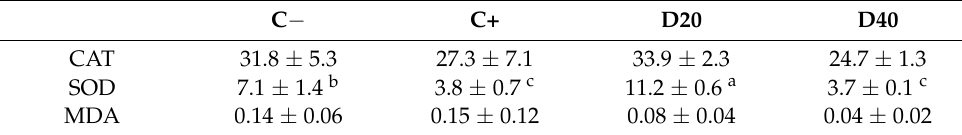
CAT, catalase; SOD, superoxide dismutase; MDA, malondialdehyde. Data obtained from five biological replicates are shown as the mean ± SE values ( n = 5). Different letters correspond to significant differences ( p < 0.05) according to Tukey’s HSD test. C − , control without high-density stress; C+, control under high-density stress; D20, experimental diet supplemented with 20 g/kg agavin under high-density stress; D40, experimental diet supplemented with 40 g/kg agavin under high-density